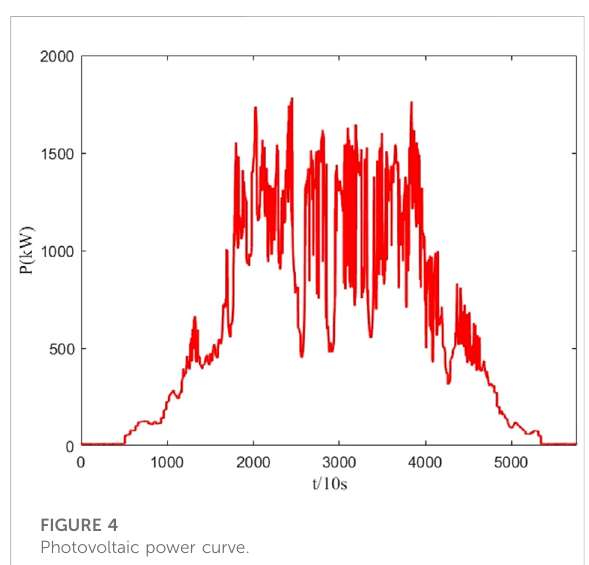
FIGURE 4 Photovoltaic power